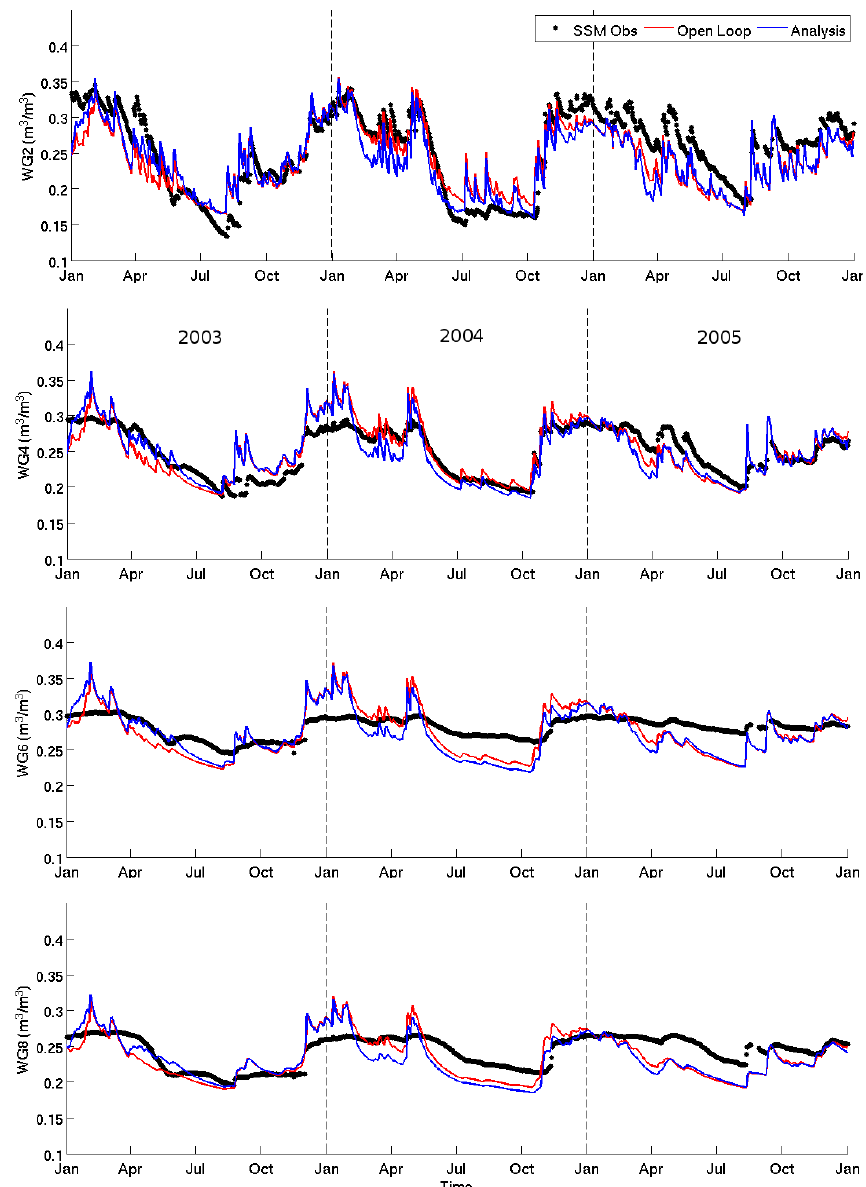
Fig. 8. Time series of soil moisture observations (black dots), soil moisture open-loop (red lines) and soil moisture analysis (blue lines) for four layers: (top) layer 2: 1-5cm, (top middle) layer 4:15-25 cm, (bottom middle) layer 6: 35-45 cm and (top) layer 8: 35-45 cm.